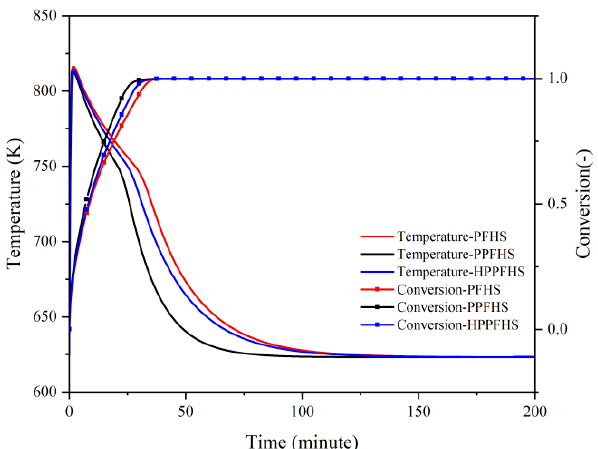
Figure 14. Conversion and temperature of the bed changed over time during dehydration ( ε = 0.8, 25 m/s).